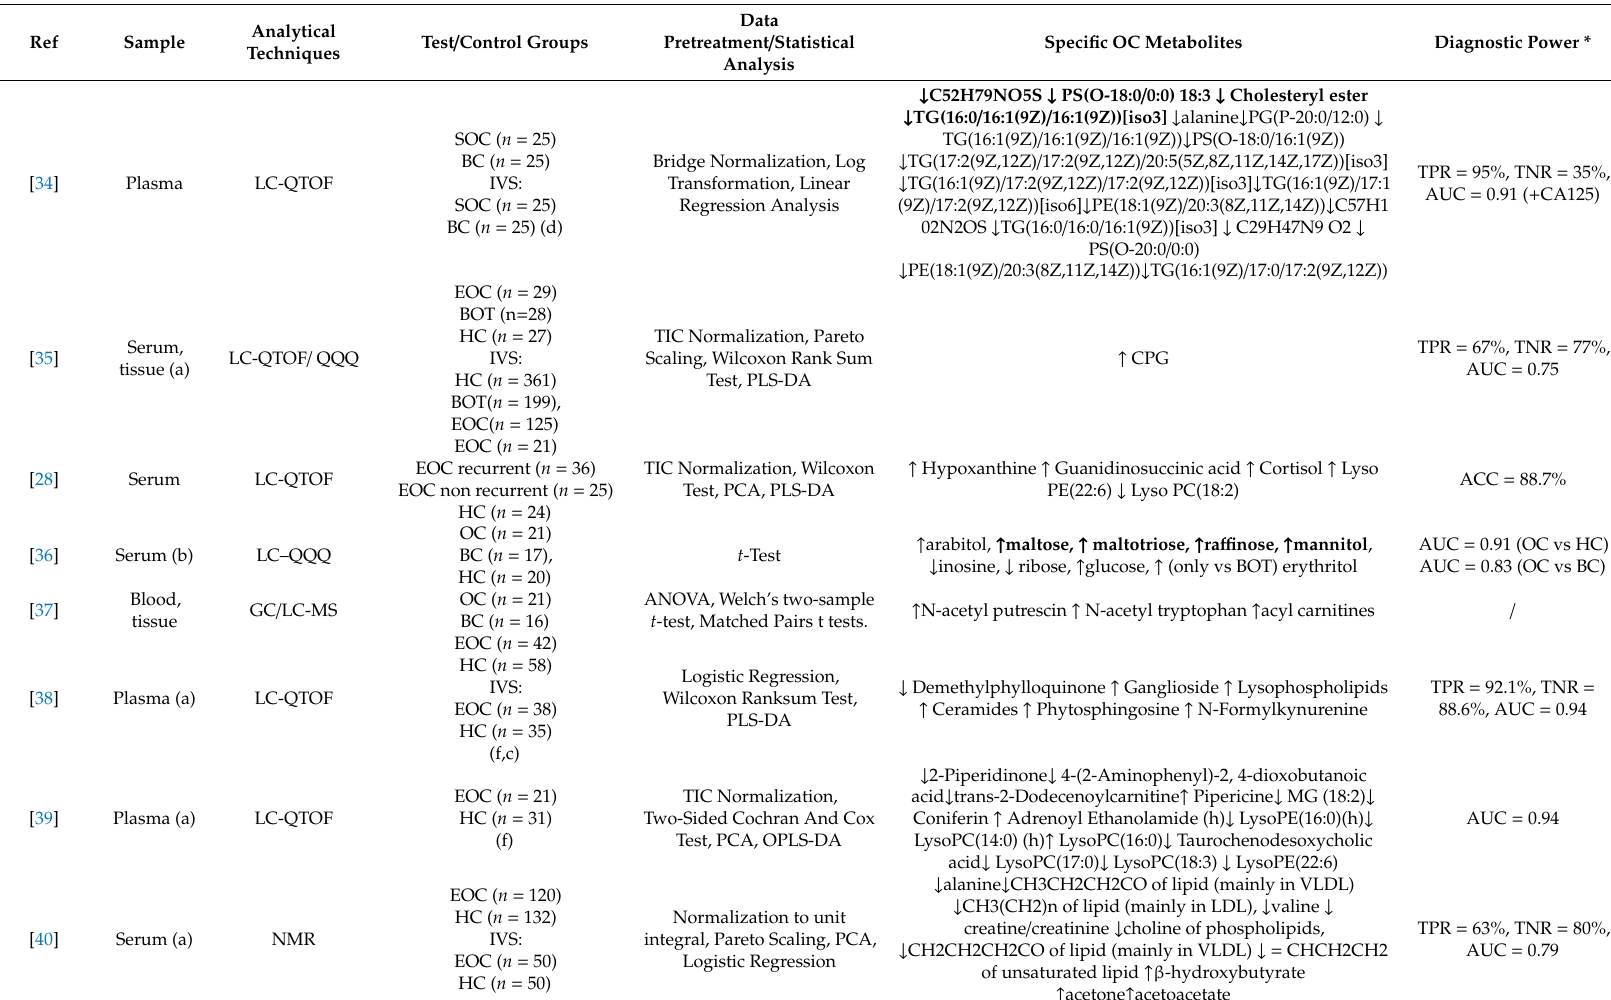
Table 1. Metabolomics studies for the discovery of OC diagnostic